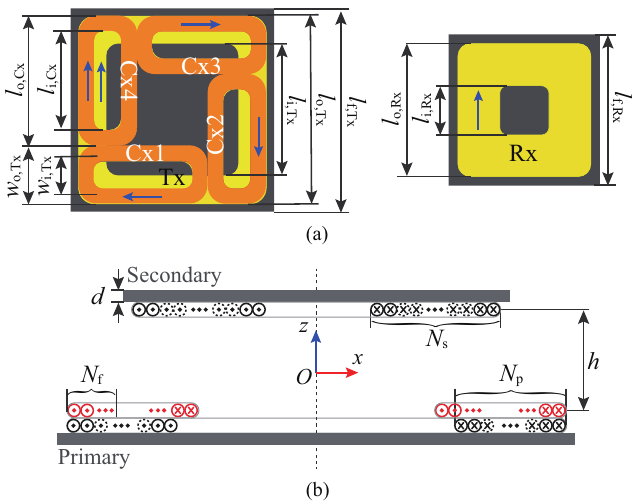
Figure 3. ( a ) Coil structure, and ( b ) Cross-section view of the proposed three-coil WPT